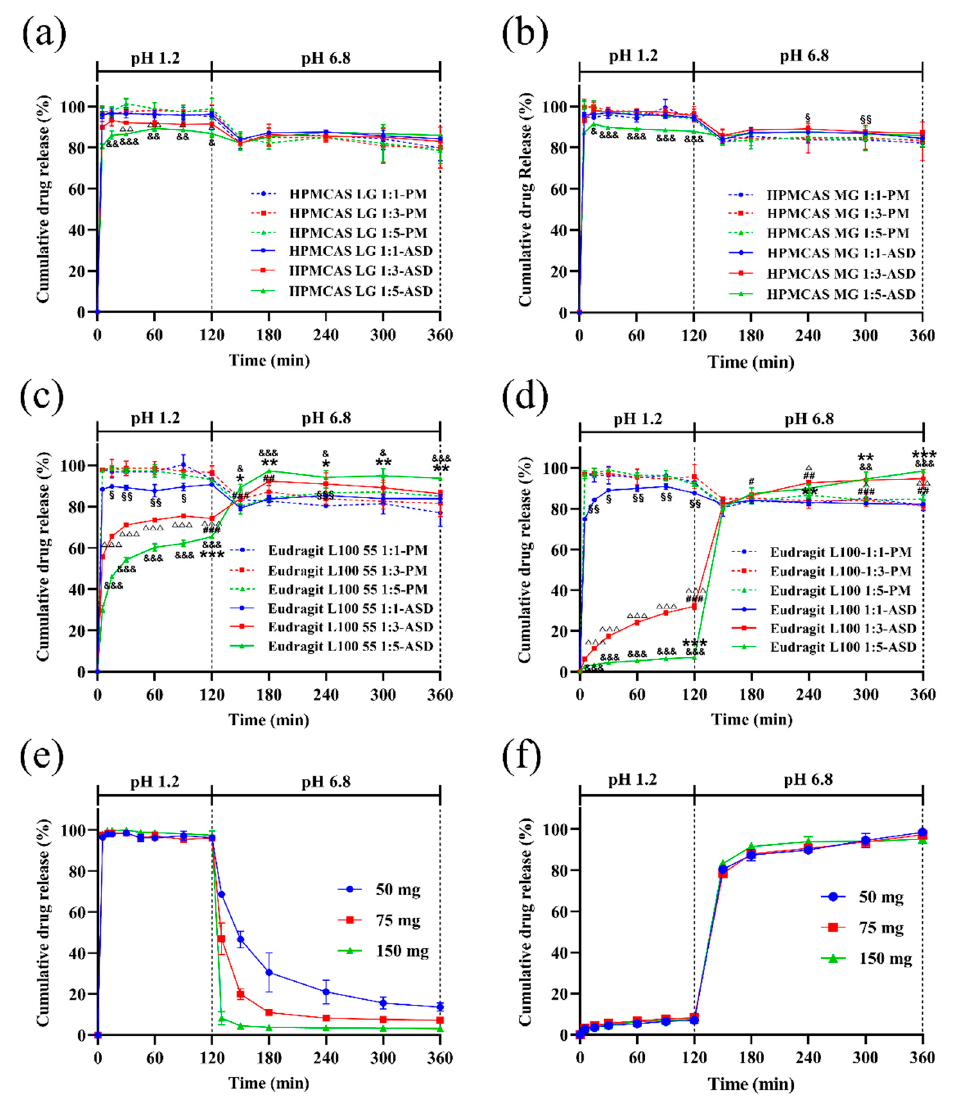
Figure 10. pH shift dissolution profiles in pH 1.2 for 120 min and pH 6.8 for 240 min (Mean ± S.D., n = 3). ( a ) HPMCAS LG–ASDs and PMs, ( b ) HPMCAS MG–ASDs and PMs, ( c ) Eudragit L100